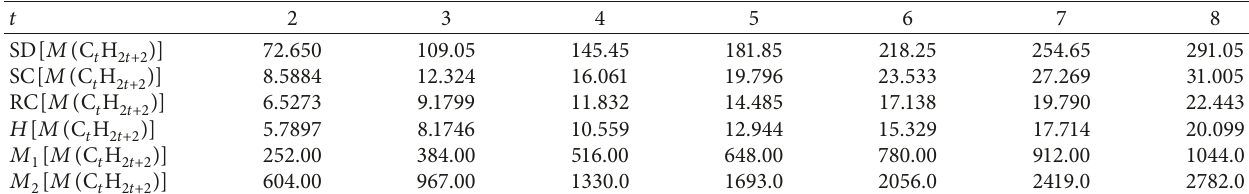
Table 2: Numerical representation of topological indices of middle graph of alkane ( C